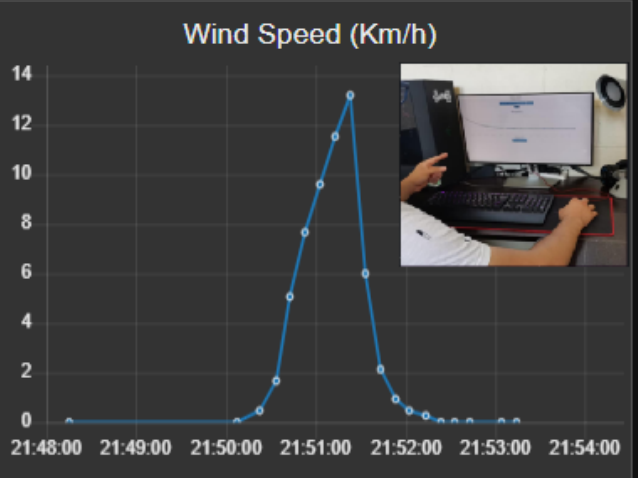
Figure 14. Instructional design: graphic level showing the weather station’s data in real-time with the open-source